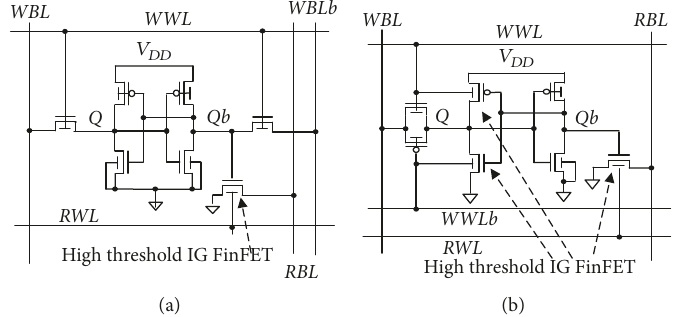
Figure 9: Reproduced from H. Yang et al. (2017) (under the Creative Commons Attribution License/public domain).